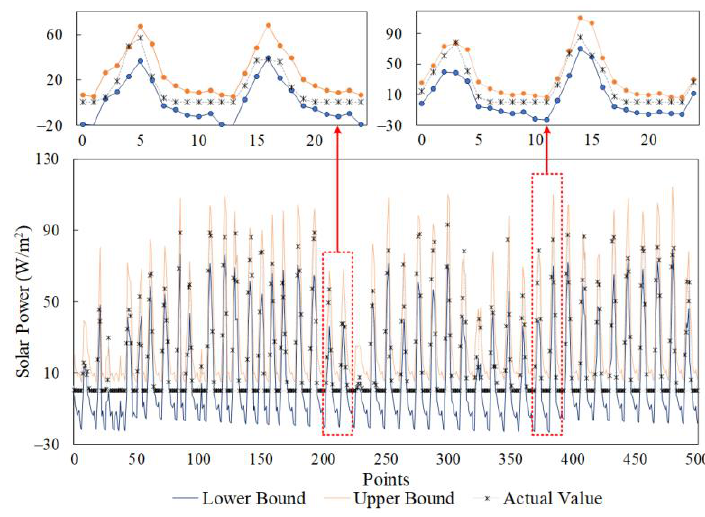
Figure 11. The prediction results obtained by SA and WI w/ ELM-AE.